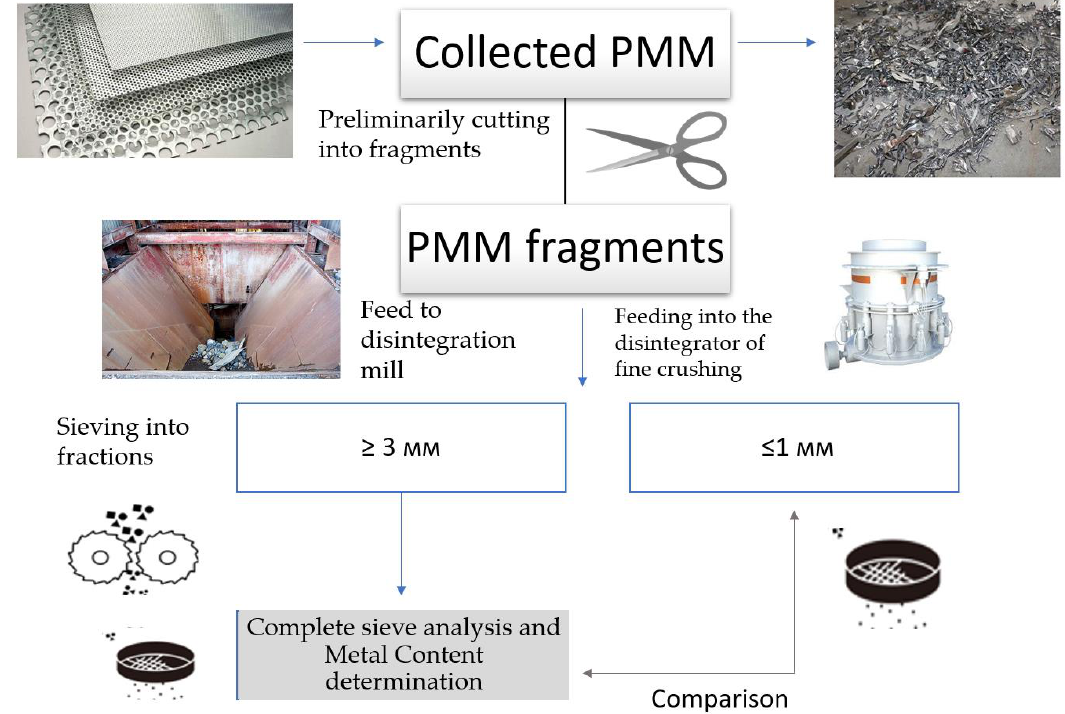
Figure 10. Scheme of processing PMM waste into powder by mechanical grinding. The disadvantage of the method is increased energy consumption and an increased percentage of pollution (Figure 11a).